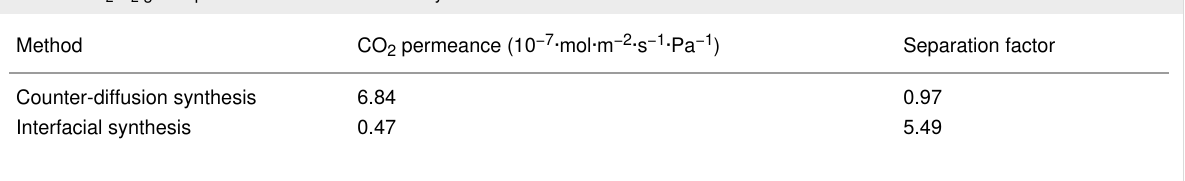
Table 3: CO 2 /N 2 gas separation of ZIF-8 membranes synthesized via two different methods. Method